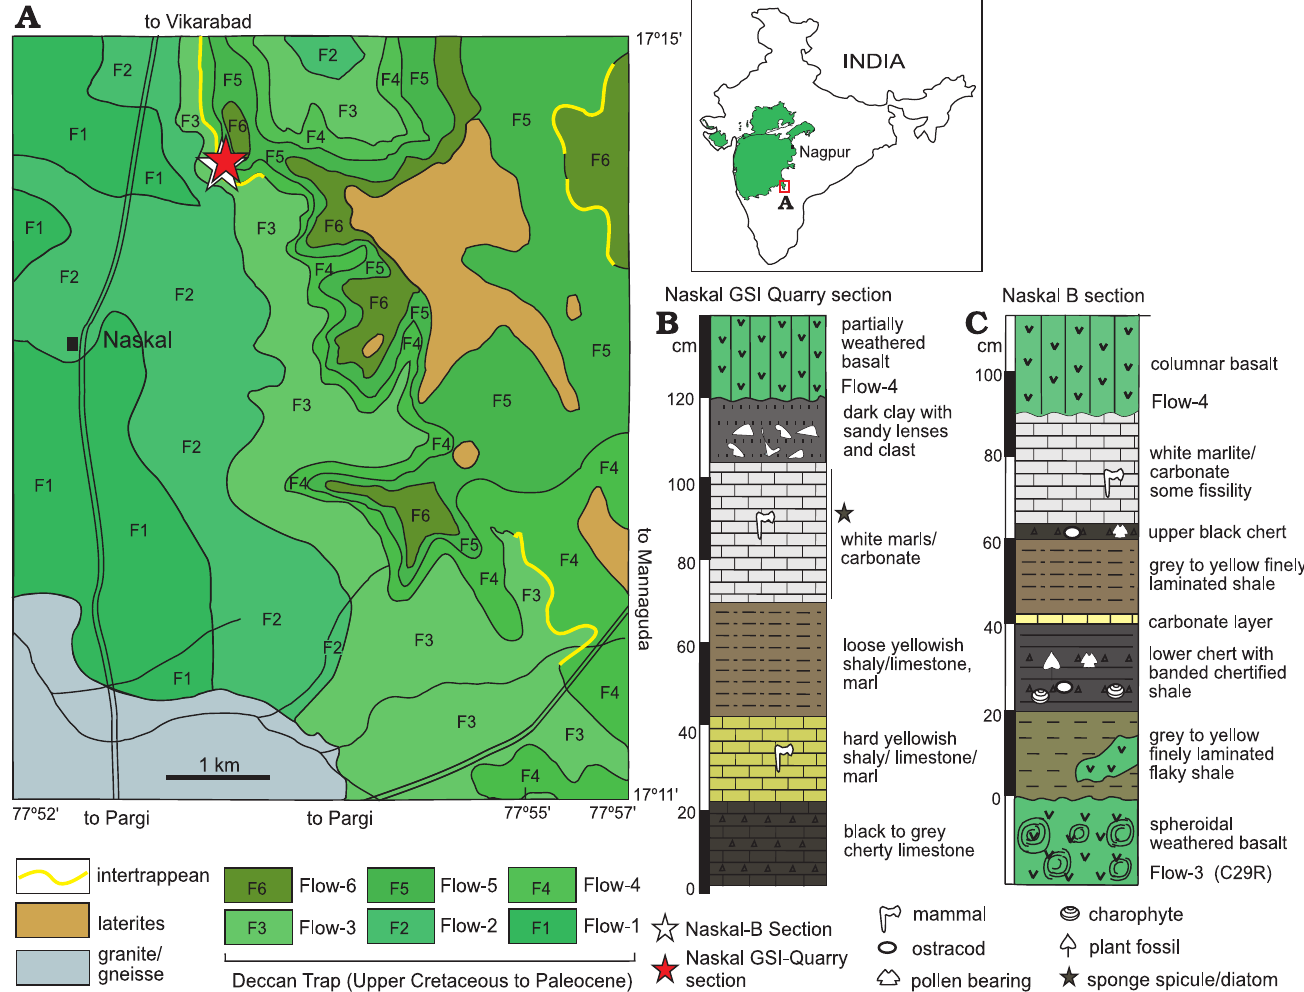
Fig. 1. Map of India showing Deccan volcanic province (green area). A . Location of Naskal intertrappean, Naskal B (white star) and Naskal GSI Quarry sections (red star); map modified after Ahluwalia (1990) and Wilson Mantilla et al. (2022). B . Sponge spicule and diatom bearing horizon in Naskal GSI Quarry section. C . Palynomorph bearing Naskal B section (modified after Wilson Mantilla et al.